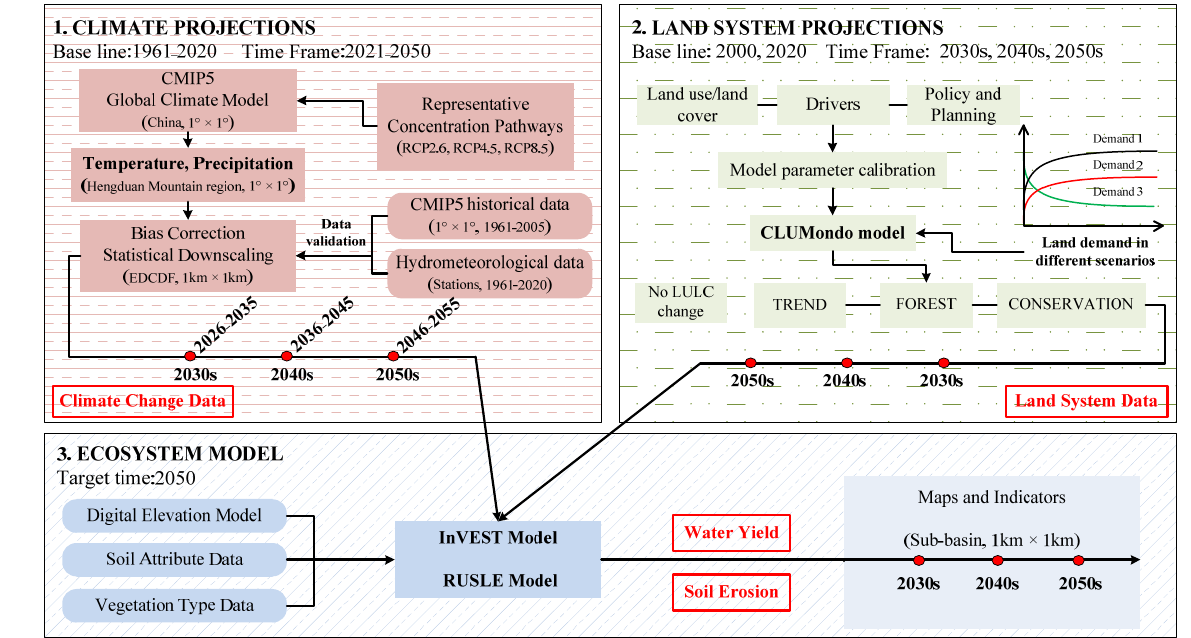
Figure 2. Framework of this study.